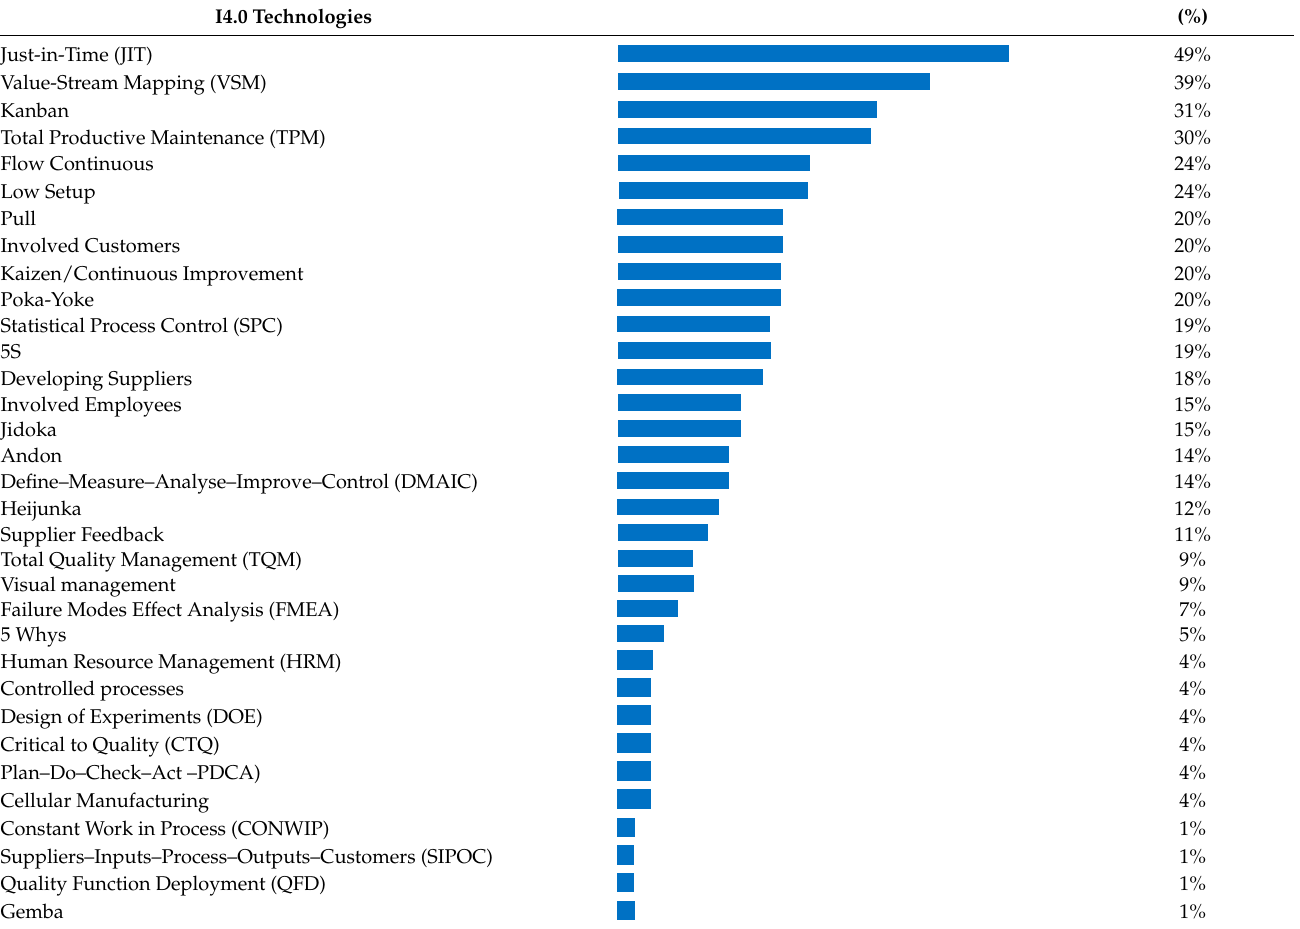
Table 6. LSS techniques and tools that integrate with I4.0, according to reviewed articles.